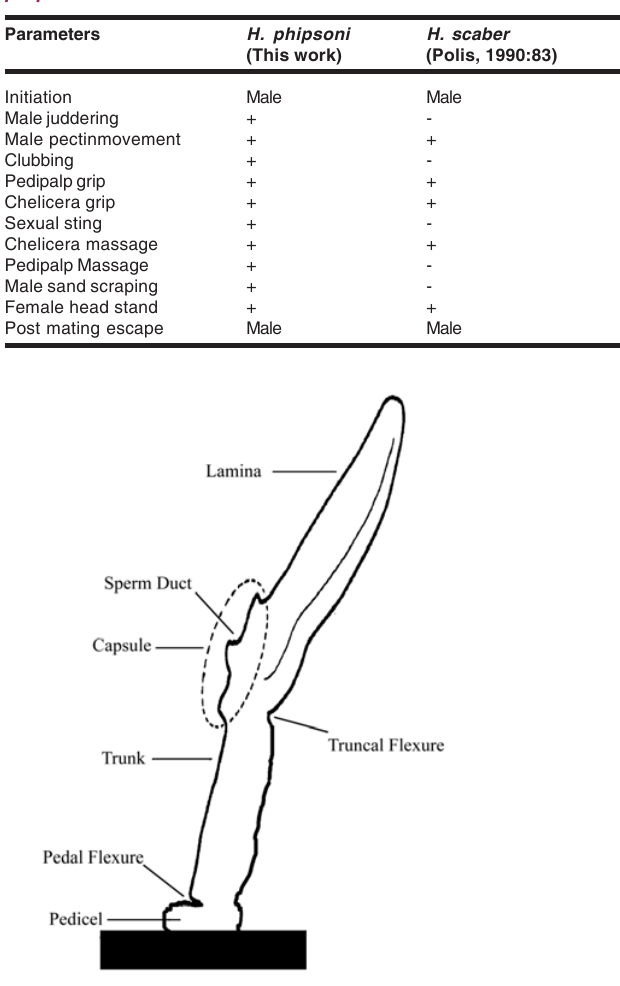
Figure 1. Diagrammatic representation of the spermatophore of H.